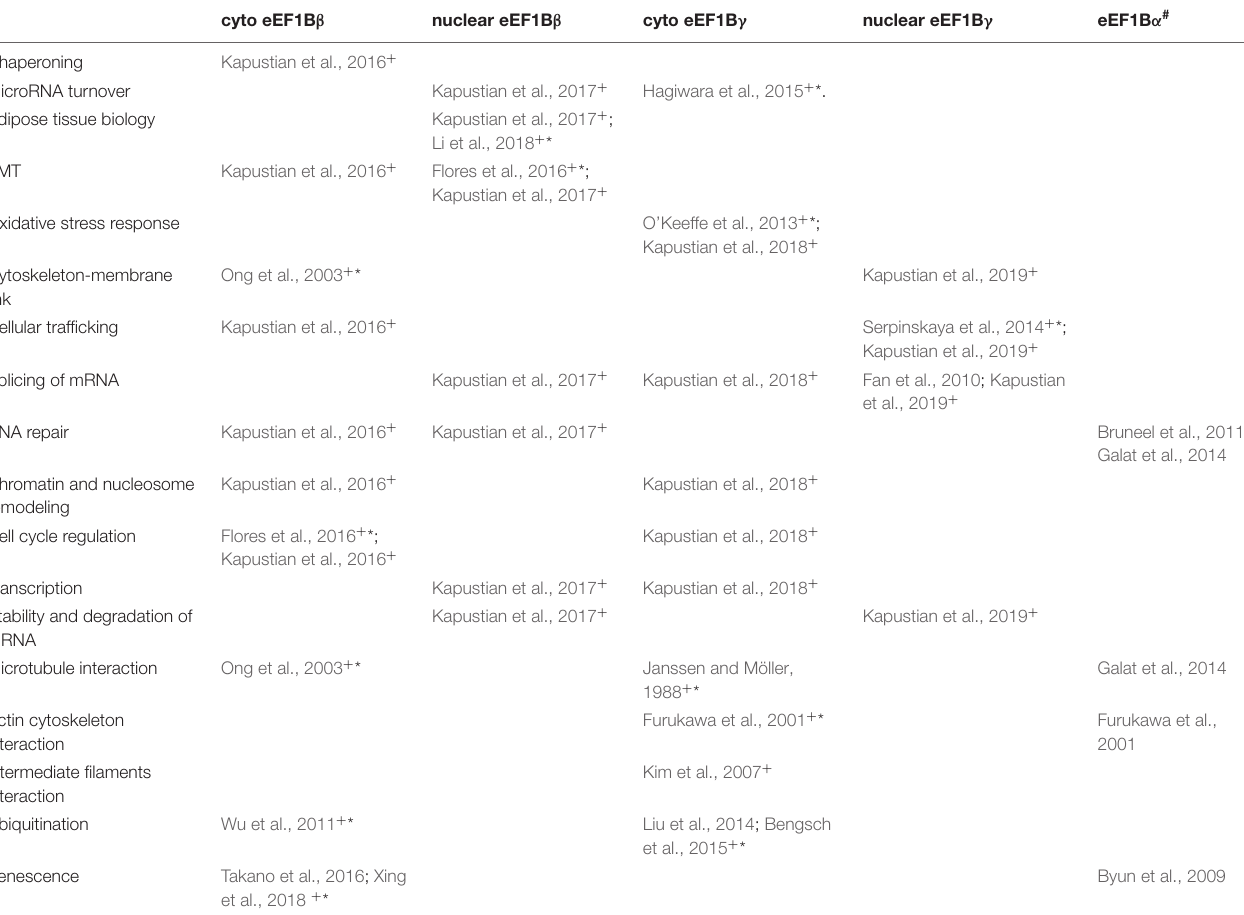
TABLE 1 | Possible non-translational involvements of eEF1B